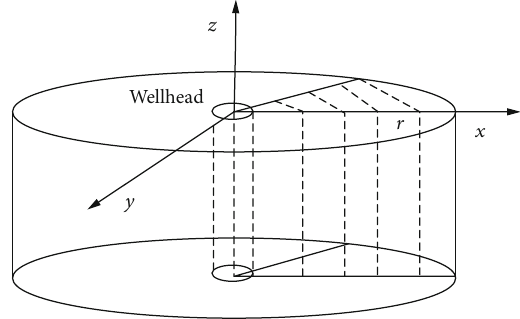
Figure 1: Schematic of development of single coal